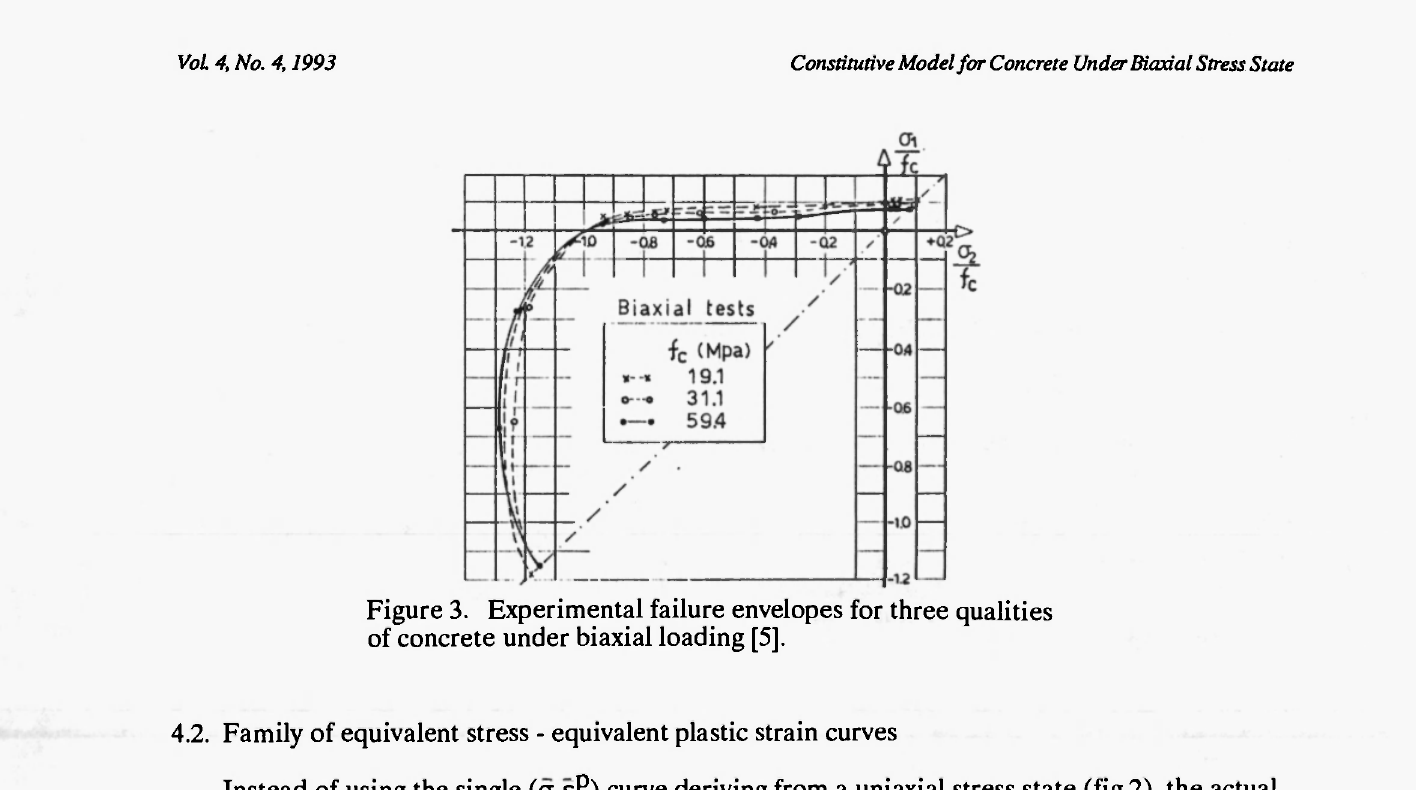
Figure 3. Experimental failure envelopes for three qualities of concrete under biaxial loading